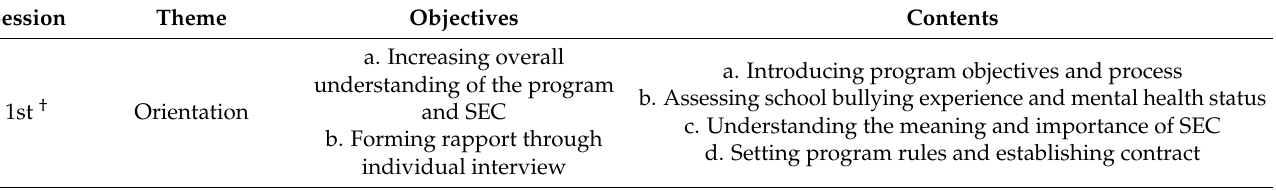
Table 1. SECE program